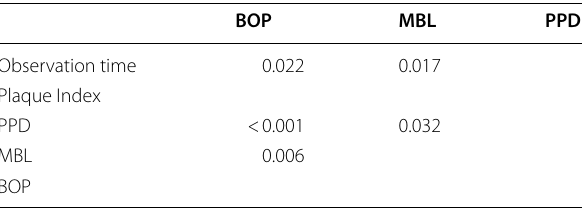
Table 3 Correlation analysis according to Spearman-Rho in the CEG (32 implants)